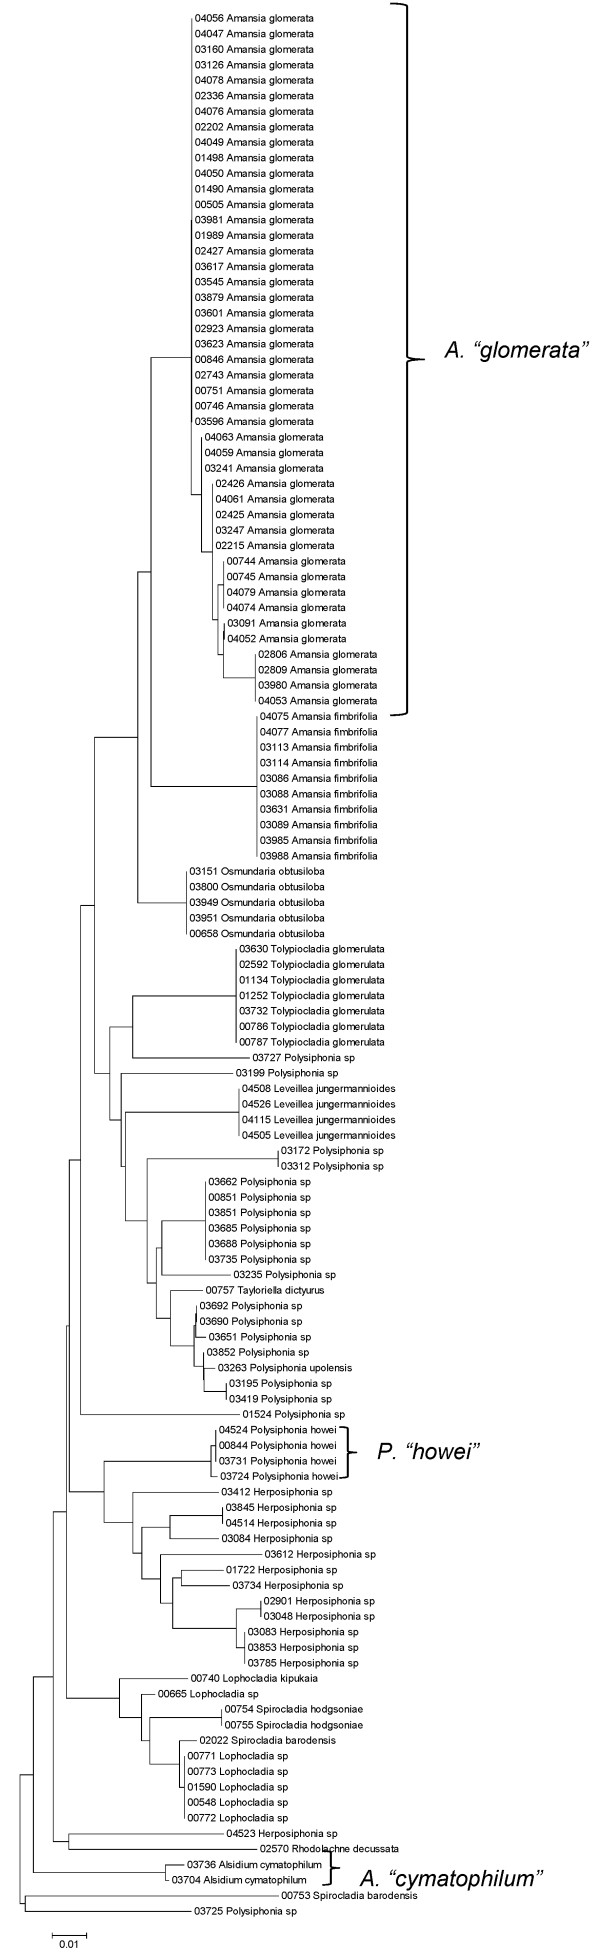
Neighbor-joining tree of UPA sequences of the family Rhodomelaceae (part 2) of the order Ceramiales. Sequence diversity based on the COI mitochondrial marker for surveyed Rhodophyta specimens belonging to the family Rhodomelaceae (excluding the Laurencia complex) of the order Ceramiales. Neighbor-joining tree is based on the Maximum Composite Likelihood nucleotide model in MEGA 4.0. Scale bar = substitutions per site.